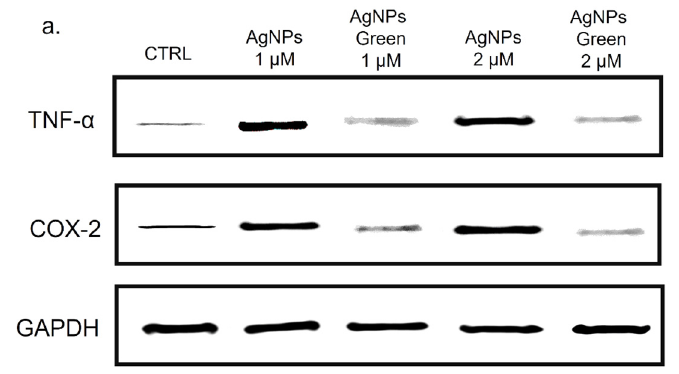
Figure 8. IL-6 ( a , b ) and IL-8 ( c , d ) levels expressed as pg/mL measured after exposure of THP-1 cells to conventional Ag NPs and green Ag NPs (1 µM and 2 µM) for 24 h and 48 h. The cytokine amount was detected in supernatants derived from the control and the treated cells by ELISA assay. The data were reported as the mean ± standard deviation of three separate experiments. p- value < 0.01 (<0.01 **) compared to the control of each time